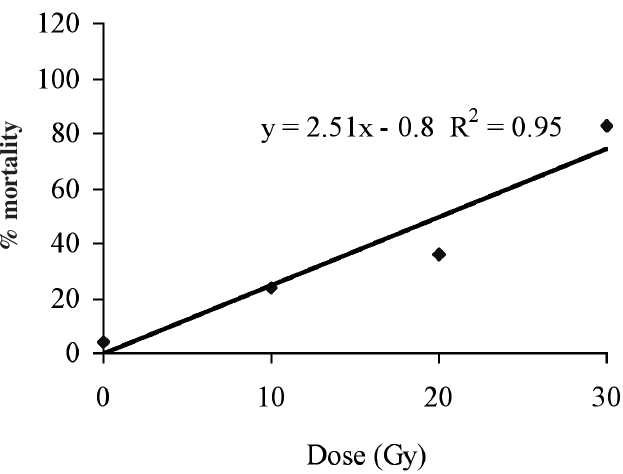
Fig. 1 - Effect of gamma irradiation on percentage mortality of grape phylloxera.